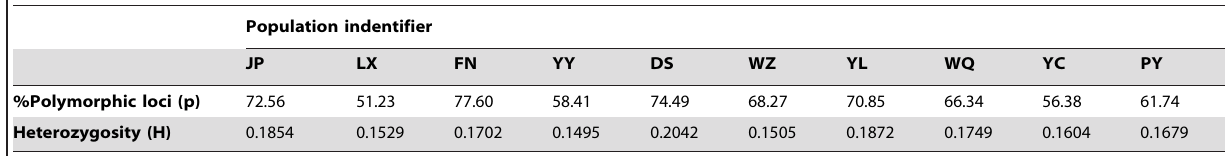
Table 2. Percentage of polymorphic loci (%P) and Nei’s heteozygosity of H. hippophaecolus